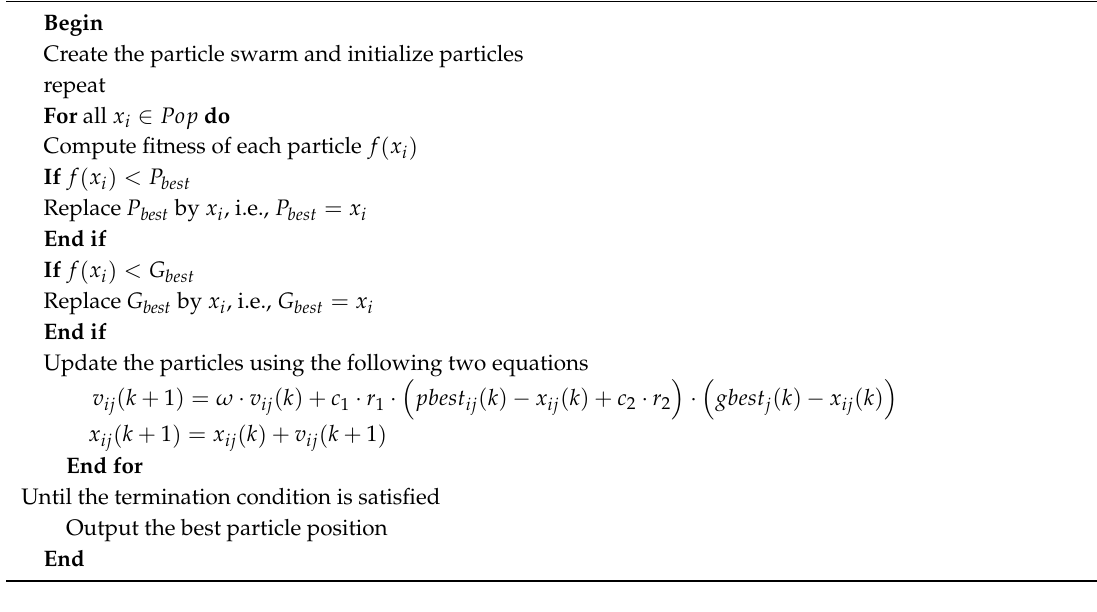
Algorithm 1 Pseudocode of PSO